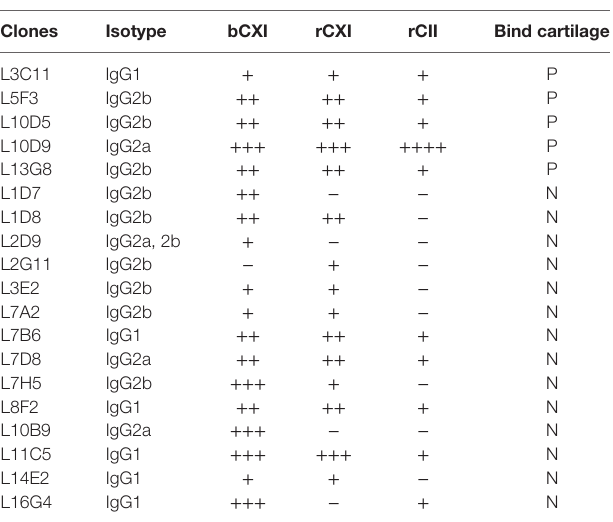
Scale for optical density (OD) values: − denotes < 3 times SEM of negative control; + denotes > mean + 3SD of negative control; ++ denotes > 0.5 OD; +++ denotes > 1.0 OD; ++++ denotes > 1.5 OD. P, positive binding to the cartilage; N, negative binding to the cartilage; rCXI, rat CXI.